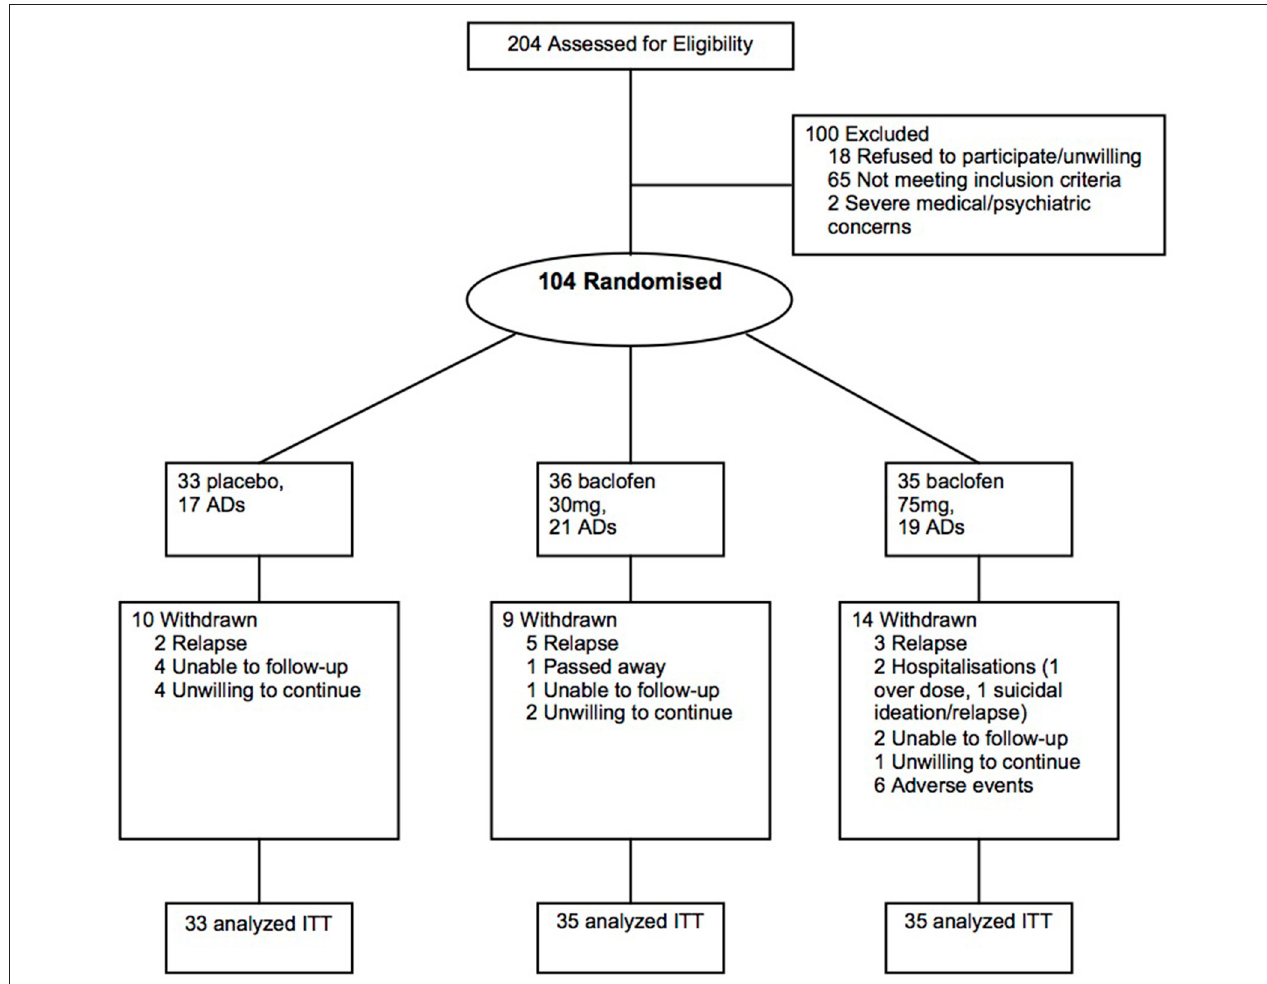
FIGURE 1 | Flow of participants through the randomized controlled 12-week trial of placebo, baclofen 30, and baclofen 75 in the treatment of alcohol dependence, including receipt of concurrent antidepressants (AD) at least two months prior to trial commencement.